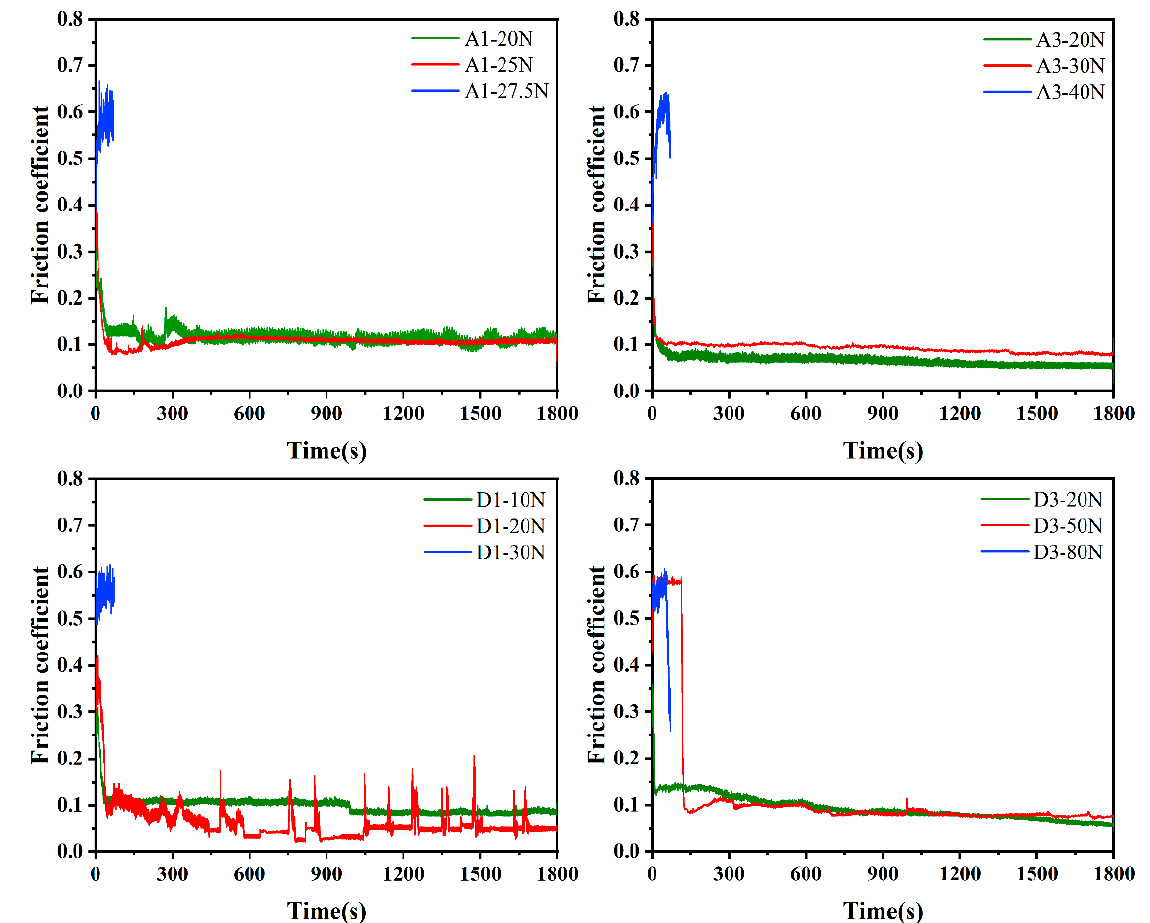
Figure 6. Friction coefficients of MCD and NCD with different loads and roughnesses.